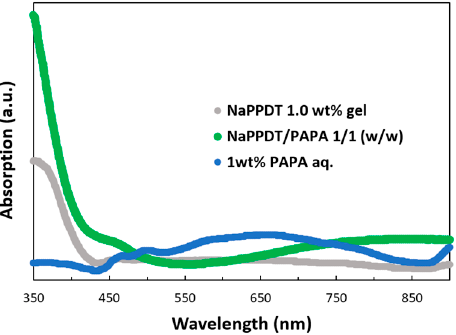
Figure 5. The UV-vis absorption bands of 1.0 wt% NaPPDT , NaPPDT / PAPA 1/1 ( w / w ) composite hydrogel, and 1.0 wt% PAPA aq. hydrogel, and 1.0 wt% PAPA